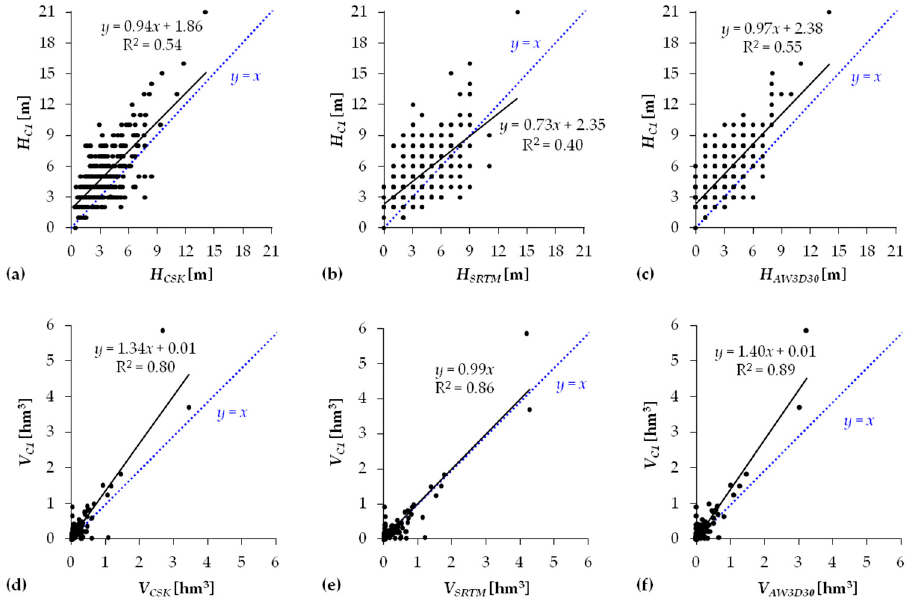
Figure 8. Comparison of ( a – c ) height ( H i ) and ( d – f ) volume ( V i ) estimates between CartoSat-1 DSM ( i = C1) and the three reference DEM datasets: COSMO-SkyMed ( i = CSK), SRTM 30 m ( i = SRTM) and AW3D30 ( i = AW3D30).